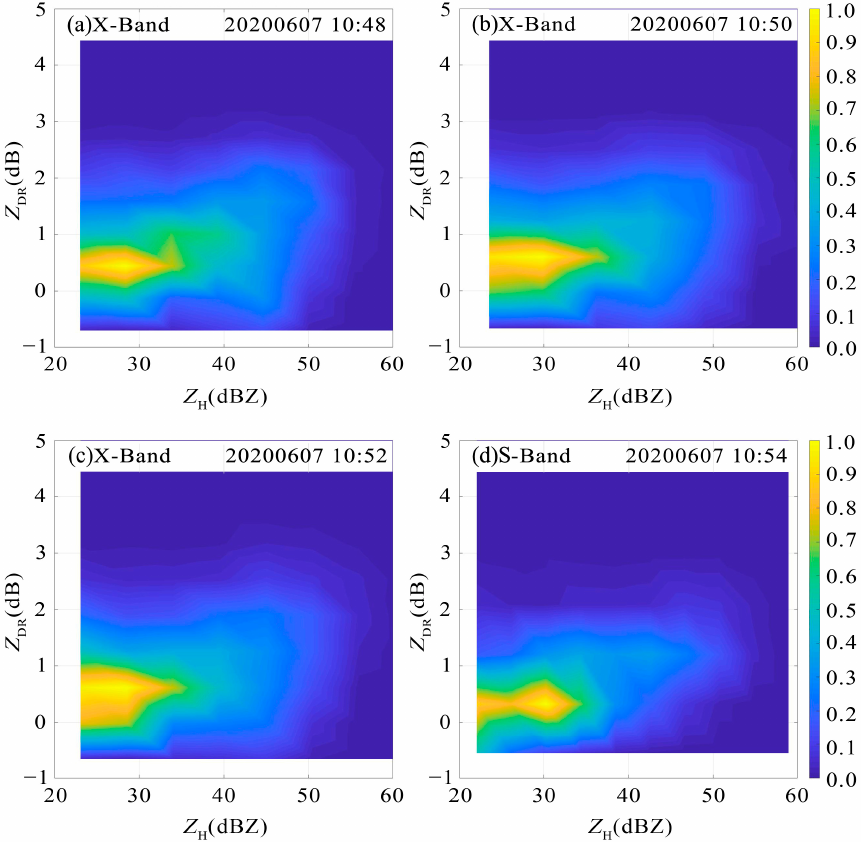
Figure 10. The normalized density of Z H - Z DR. in the pre-summer rainband observed by the Huadu X-band PAR at ( a ) 10:48, ( b ) 10:50, ( c ) 10:52, and ( d ) the S-band radar at 10:54 on 7 June